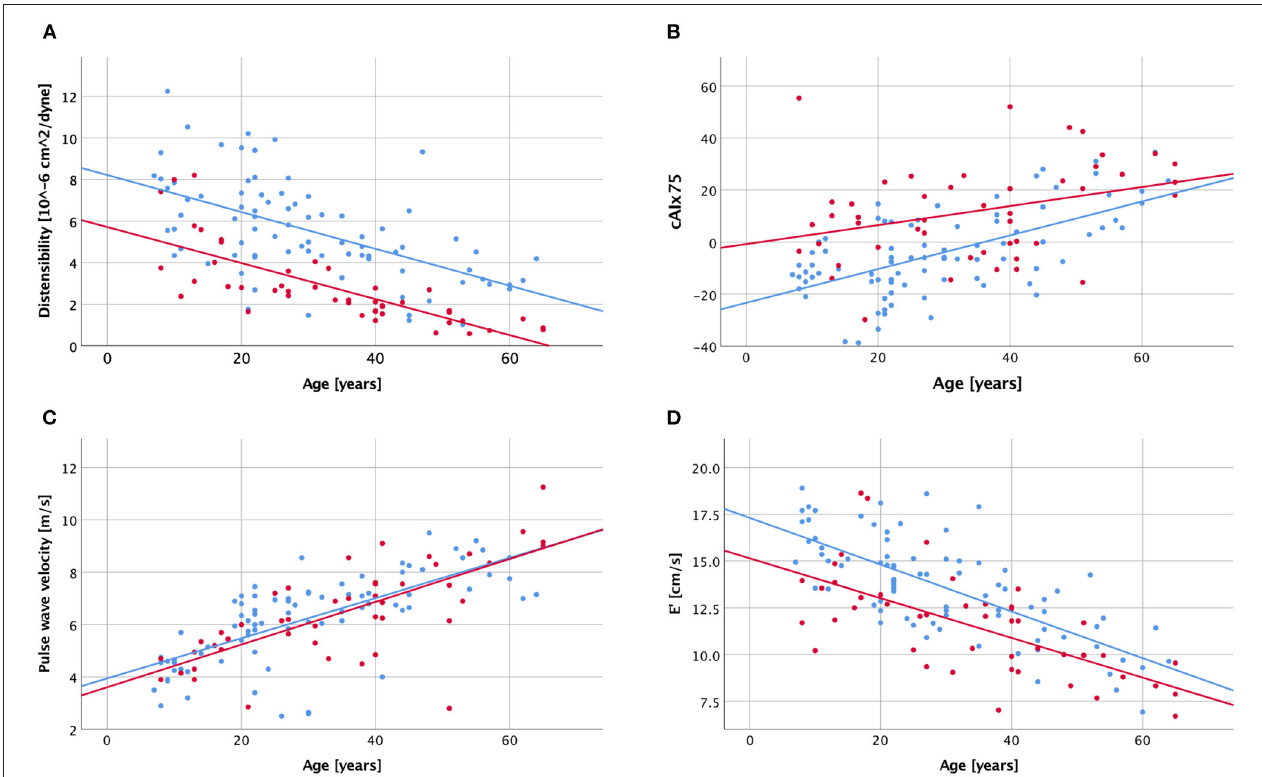
FIGURE 2 | Scatter plot visualizing correlations between age and ascending aortic distensibility (A) , central augmentation index corrected to a heart rate of 75/min [cAIx75; B ], carotid-femoral pulse wave velocity (C) , and diastolic function [E’; D ] with a history of bicuspid aortic valve (red dots and regression line) and healthy controls (blue dots and regression